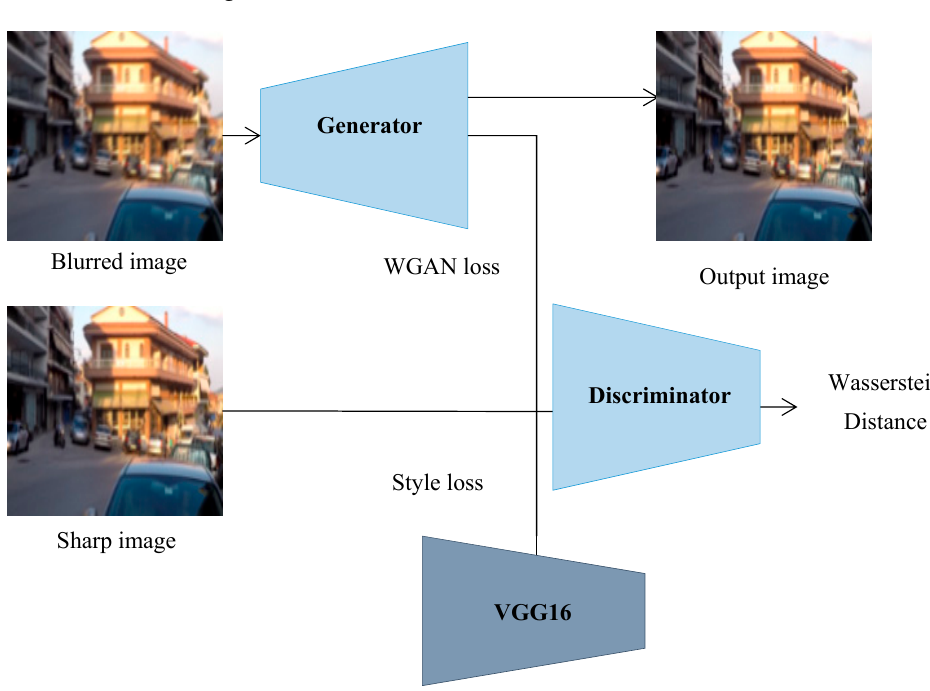
Figure 13. Architecture of discriminator in WGAN-GP.